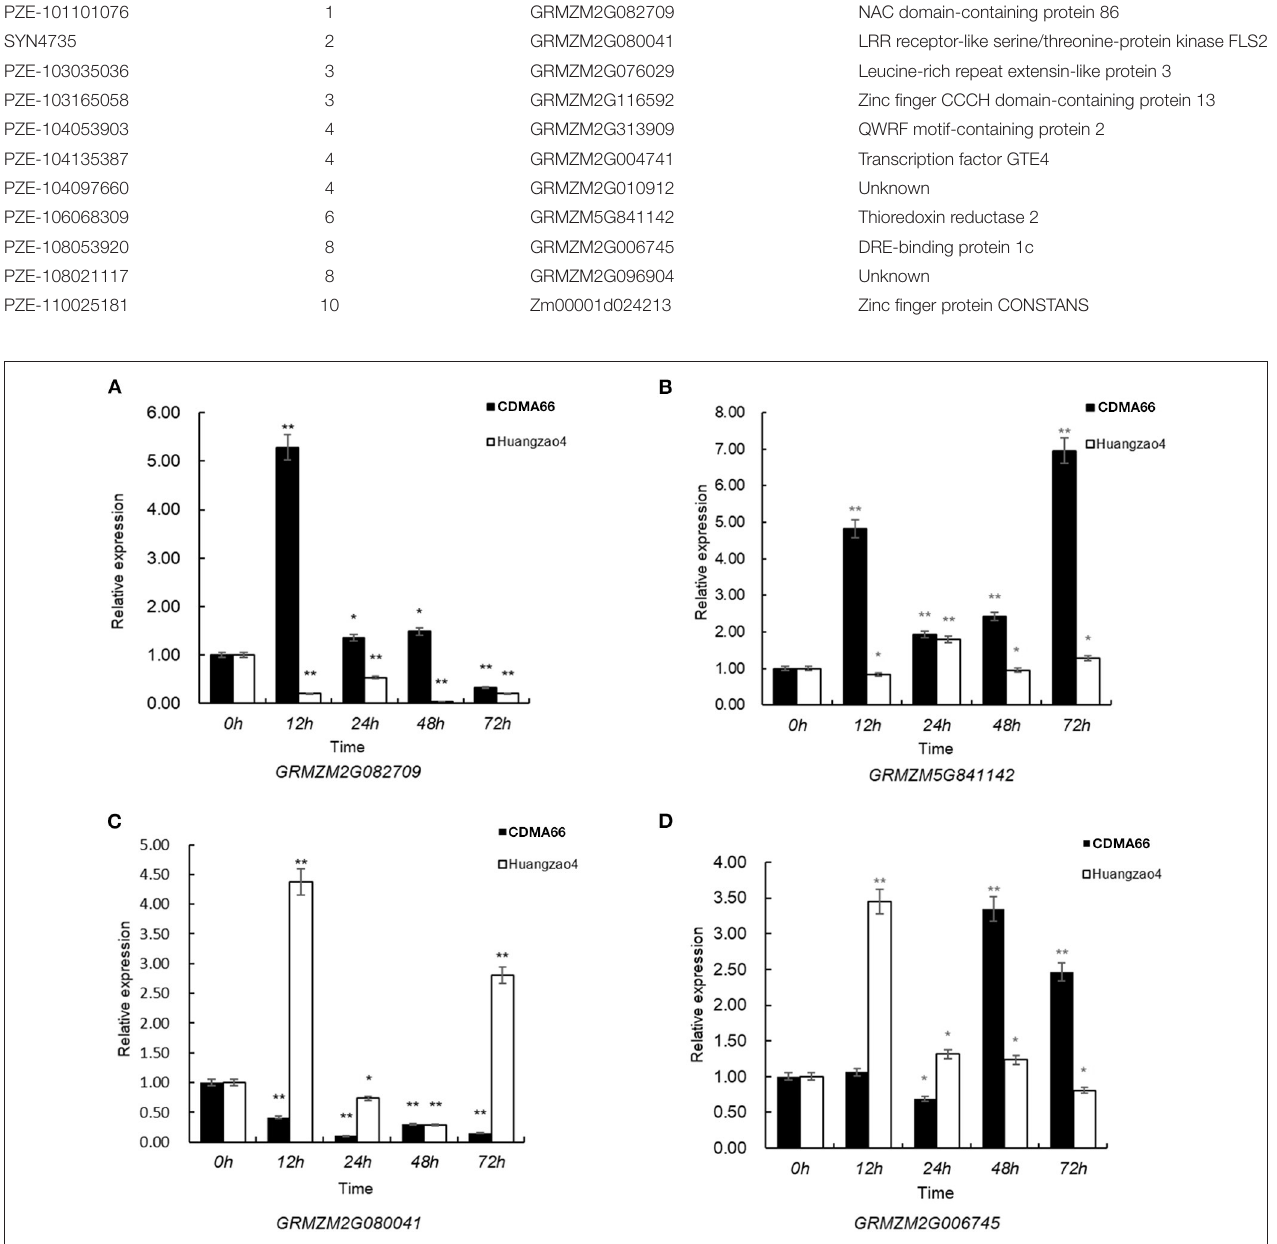
FIGURE 7 | Relative expression of the candidate genes. (A) GRMZM2G082709; (B) GRMZM5G841142; (C) GRMZM2G080041; (D) GRMZM2G006745. ** P < 0.01 and * P < 0.05,